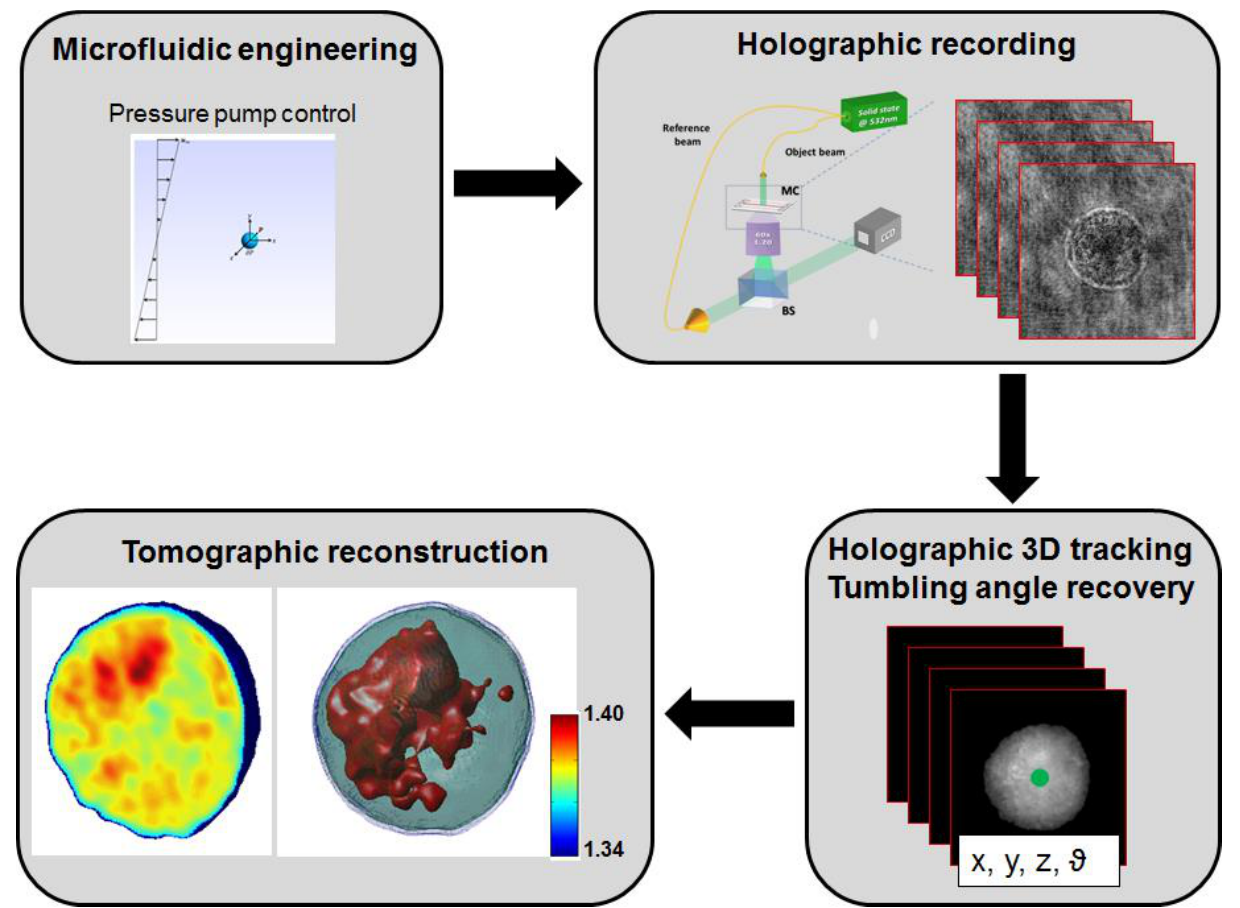
Fig. 1. Continuous TFC by microfluidic engineering